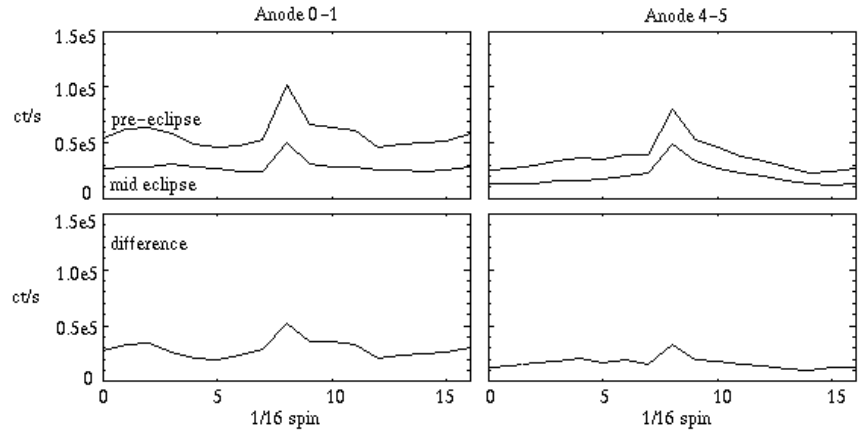
Fig. 9. Superposed spins of ∼ 6eV data, centred on the Sun direction, just before the start of the eclipse and mid-eclipse: anode 0–1 (look direction along spin axis) on the left, anodes 4–5 (look direction in spin plane) on the right. Top panel shows pre-eclipse (upper line) and mid-eclipse (lower line) data, lower panel shows the difference between the